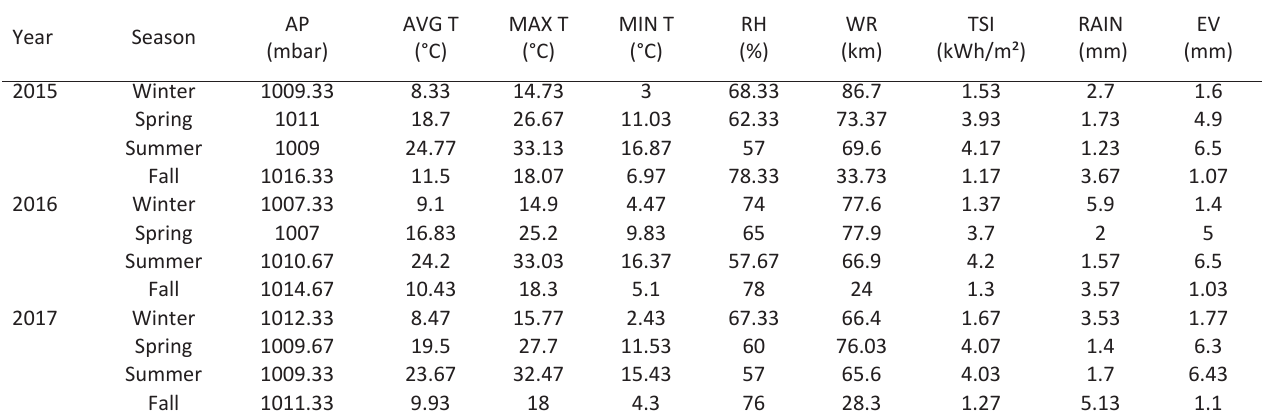
AP= atmospheric pressure; AVG T= medium air temperature; MAX T= maximum air temperature; MIN T= minimum air temperature; RH= relative air humidity; WR= wind run; GHI= global horizontal irradiation; RAIN= rainfall; EV= evaporation. a Processed from Ce.Spe.Vi database, Pistoia (http://www.cespevi.it/meteo.htm; Paolo Marzialetti © 1996/2018 Ce.Spe.Vi.